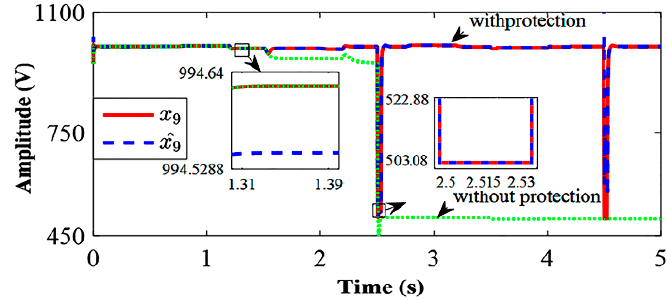
Figure 14. Capacitor output current during fault occurrence.